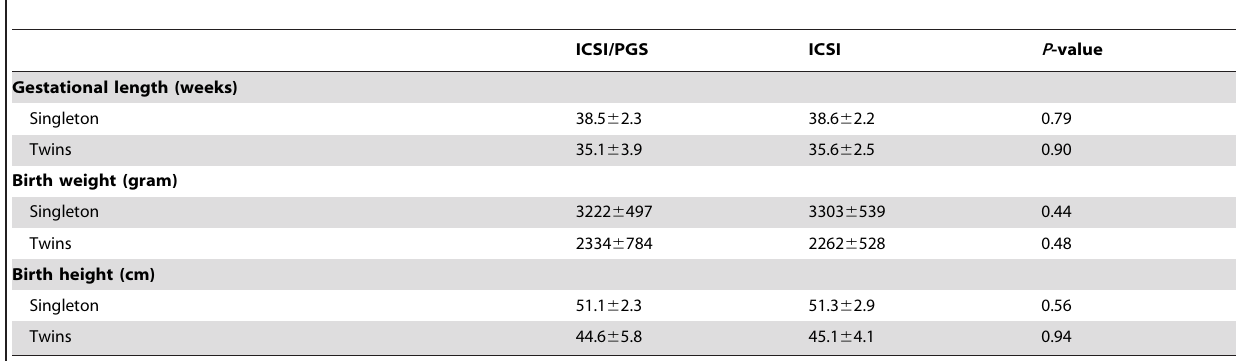
Table 3. Mean gestational length, and birth weight and height in ICSI/PGS children compared with ICSI children.